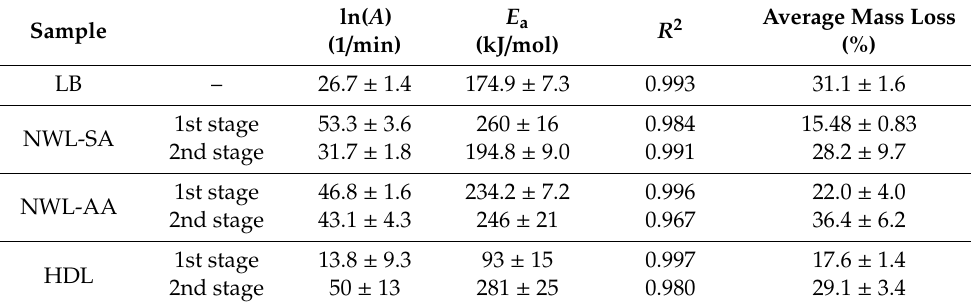
Table 5. Kinetic parameters obtained by a nonlinear least squares